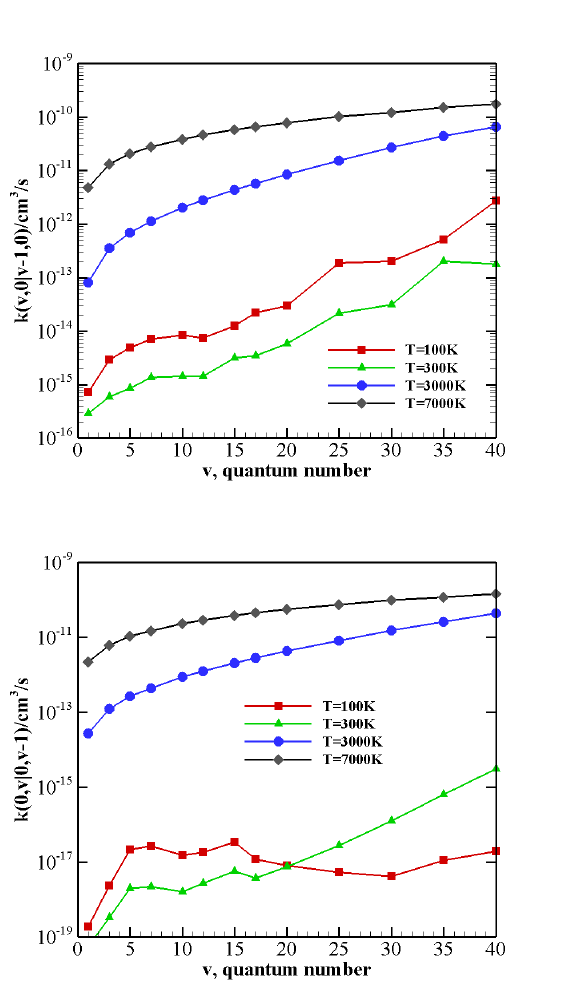
Figure 8. Single quantum V–T/R rate coefficients as a function of the vibrational quantum number v at different temperature values for transitions ( upper panel ) CO ( v ) + N 2 ( 0 ) → CO ( v − 1 ) + N 2 ( 0 ) ;